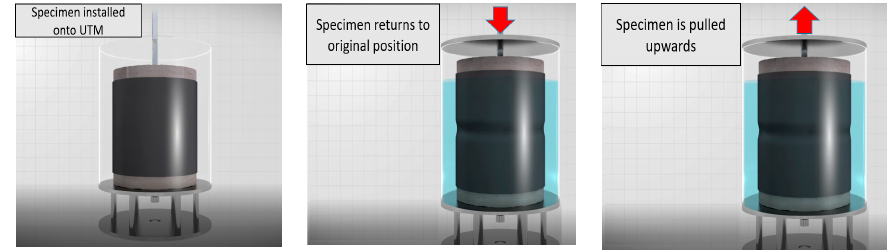
Figure 6. Strain concentration ratio evaluation method by concrete joint movement simulation.